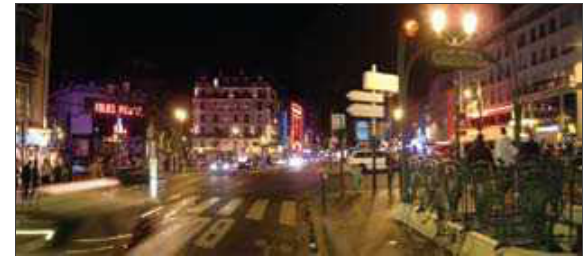
Fig. 4. Pigalle Square in Paris